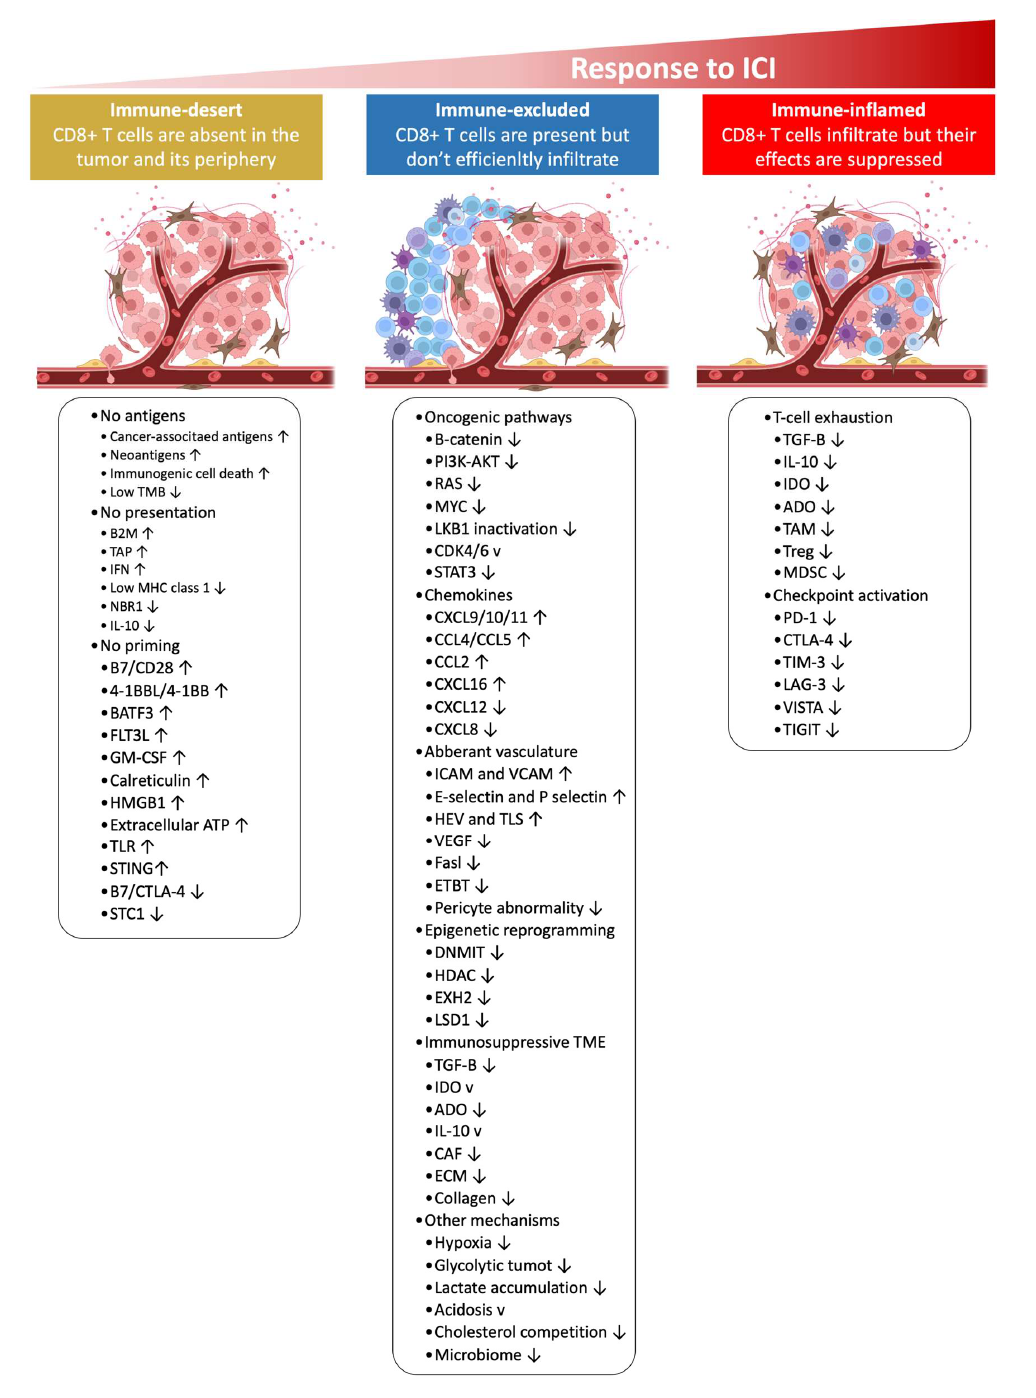
Figure 2. Mechanisms of distinct tumor phenotypes, including immune-inflamed, immune-desert, and immune-excluded tumors, are associated with specific inhibitory and stimulatory biological mechanisms. Immune-inflamed tumors are permissive to immune cell infiltration; however, immune cells in the TME can be suppressed due to checkpoint activation. On the other hand, immune-desert tumors may be devoid of T cell priming due to the lack of tumor antigens, defective antigen processing and presentation processes, or impaired interactions between dendritic cells and T cells. The immune-excluded tumors, on the other hand, may display aberrant chemokines, activated oncogenic pathways, hypoxia, aberrant vasculature, or an immunosuppressive TME (e.g., stromal barriers). Adapted from ref. [124]. ↓ (downward arrow), inhibitors; ↑ (upward arrow), stimulatory factors. Created with BioRender.com (URL accessed on 18 November 2022). Definitions of abbreviations are found in the abbreviations list at the end of the